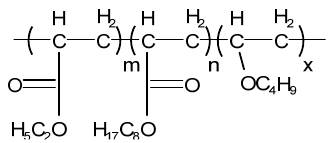
Figure 8. Structure of T911.